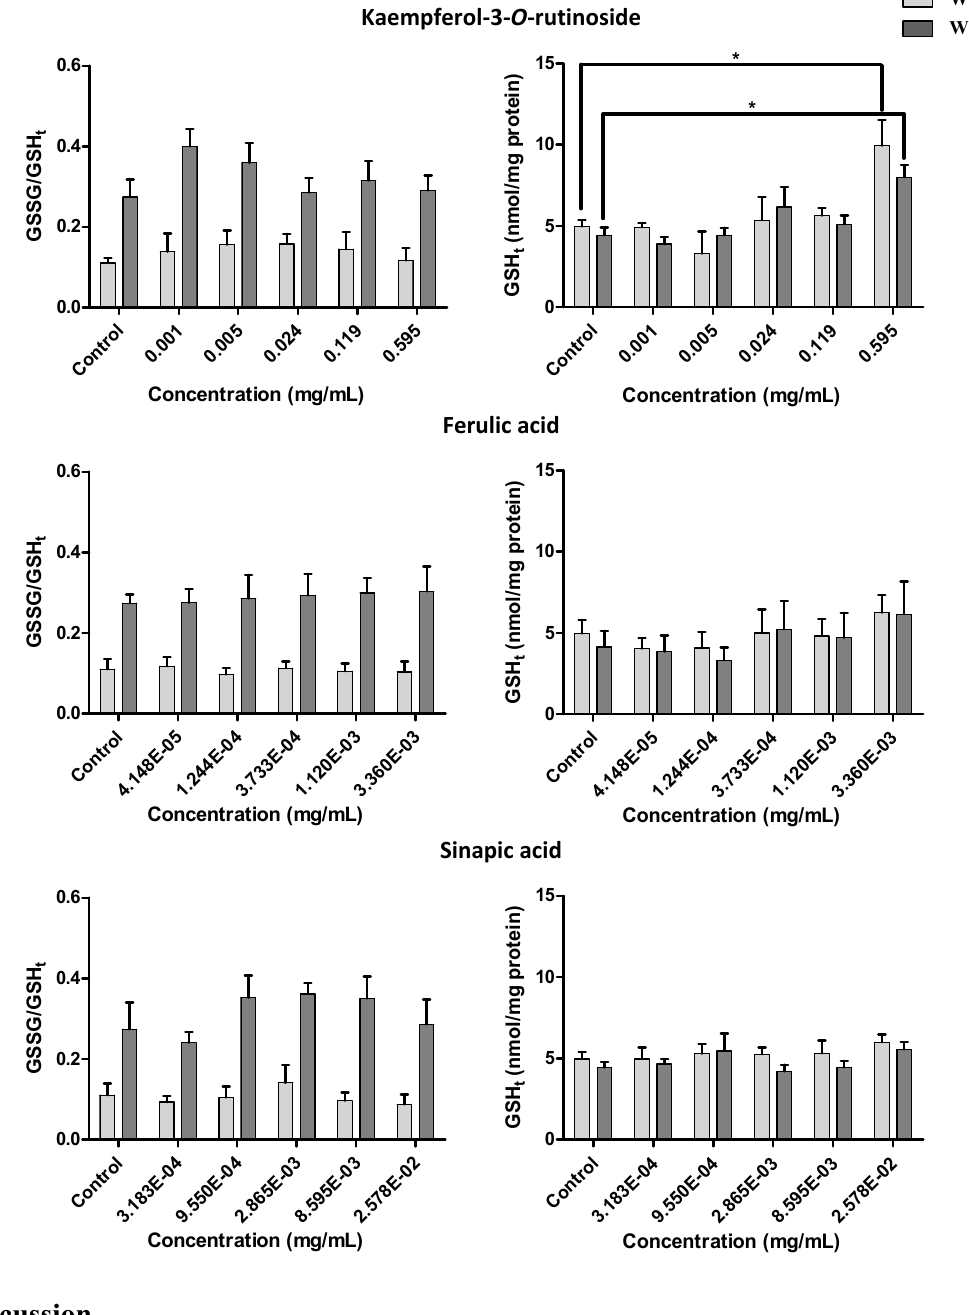
Figure 9. Effect of kaempferol-3- O -rutinoside, ferulic and sinapic acids on GSSG/GSH and on total glutathione content of V79 cells, after 24 h treatment, with and without H O -induced oxidative stress. Values show mean ± SE (n = 4). Mean values were 2 2 significantly different compared with the respective control ( * p <